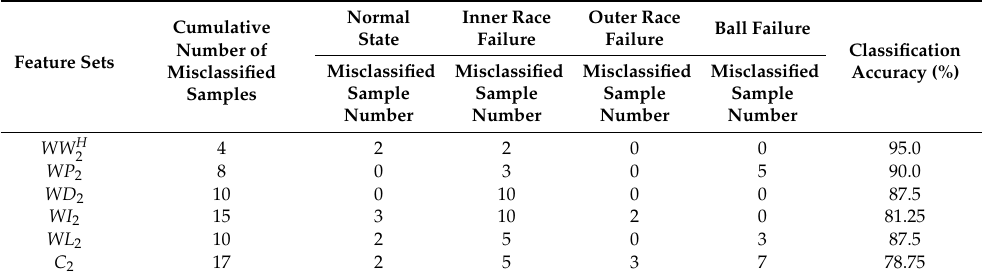
Table 5. Comparison of test ‐ classification results of six different fault feature sets in experiment data 2 based on SVM model.